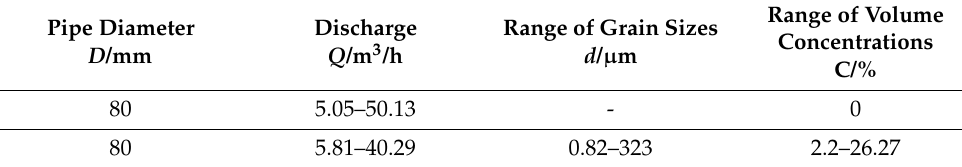
Table 1. Pipe/sediment properties and sediment concentration